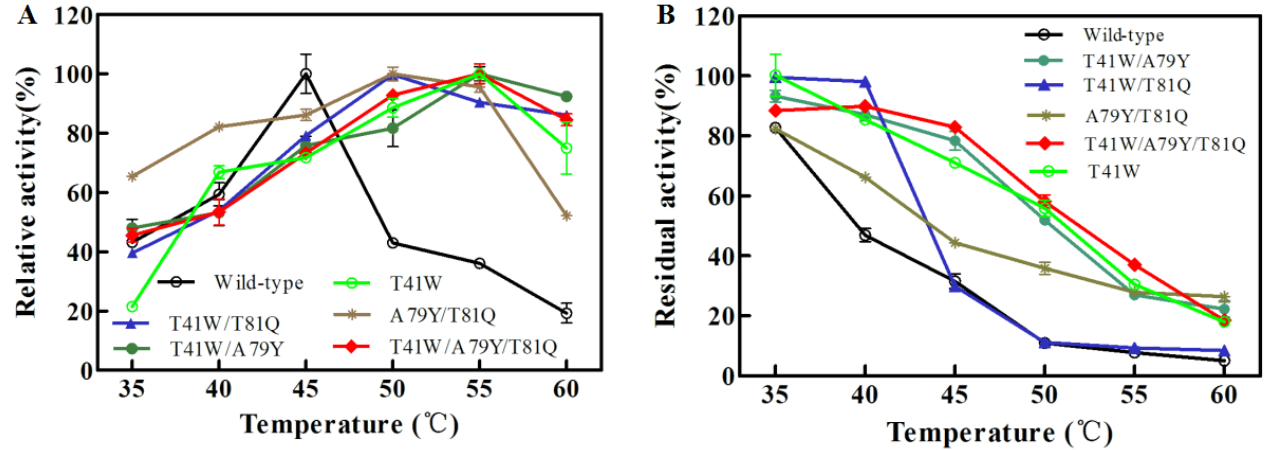
Figure 6. Optimal temperature ( A ) and thermostability ( B ) of the wild-type XynASP and combined mutants. The highest activity of each wild-type and mutant was set as 100%.